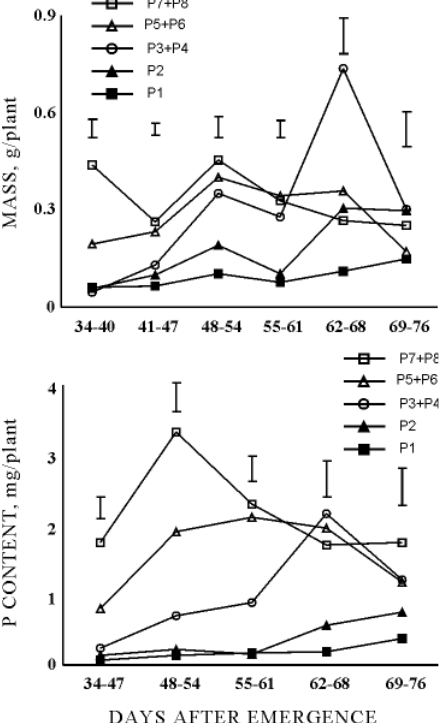
Figure 1. Number of live trifoliate leaves during the growth cycle of common bean plants grown at eight P levels applied to the soil (in mg kg -1 P): P1 5, P2 10, P3 20, P4 40, P5 80, P6 160, P7 320 P8 640; some P levels were grouped. Vertical bars represent the least significant difference (Tukey test at 0.05 significance level), and compare P levels within each day.